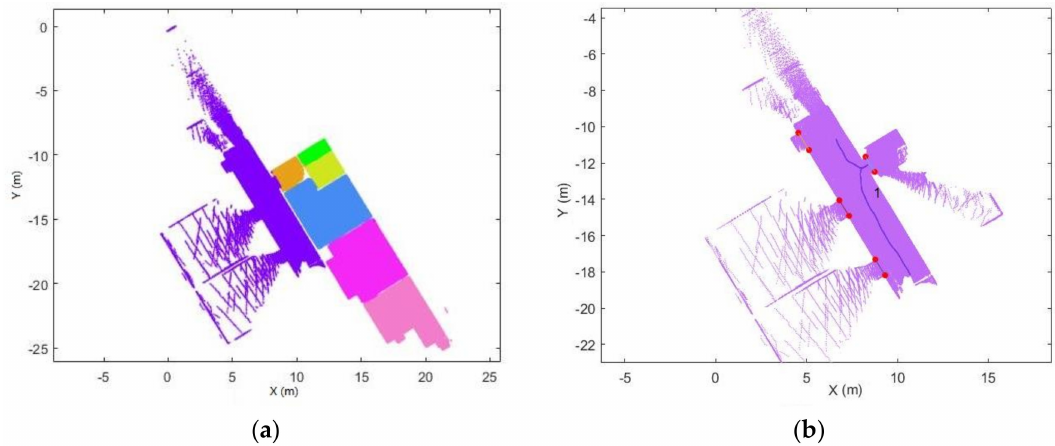
Figure 15. Example of the subsets of the point cloud. ( a ) all point cloud subsets. ( b ) one of the point cloud subsets (different spaces shown in different